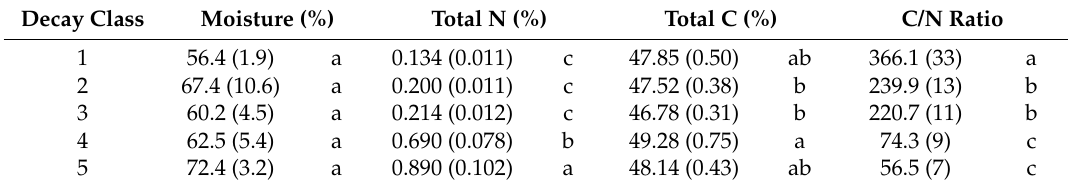
Table 4. Average values of moisture, total C and N contents, and C/N ratio of the cores from the different decay classes of black pine deadwood; standard errors in